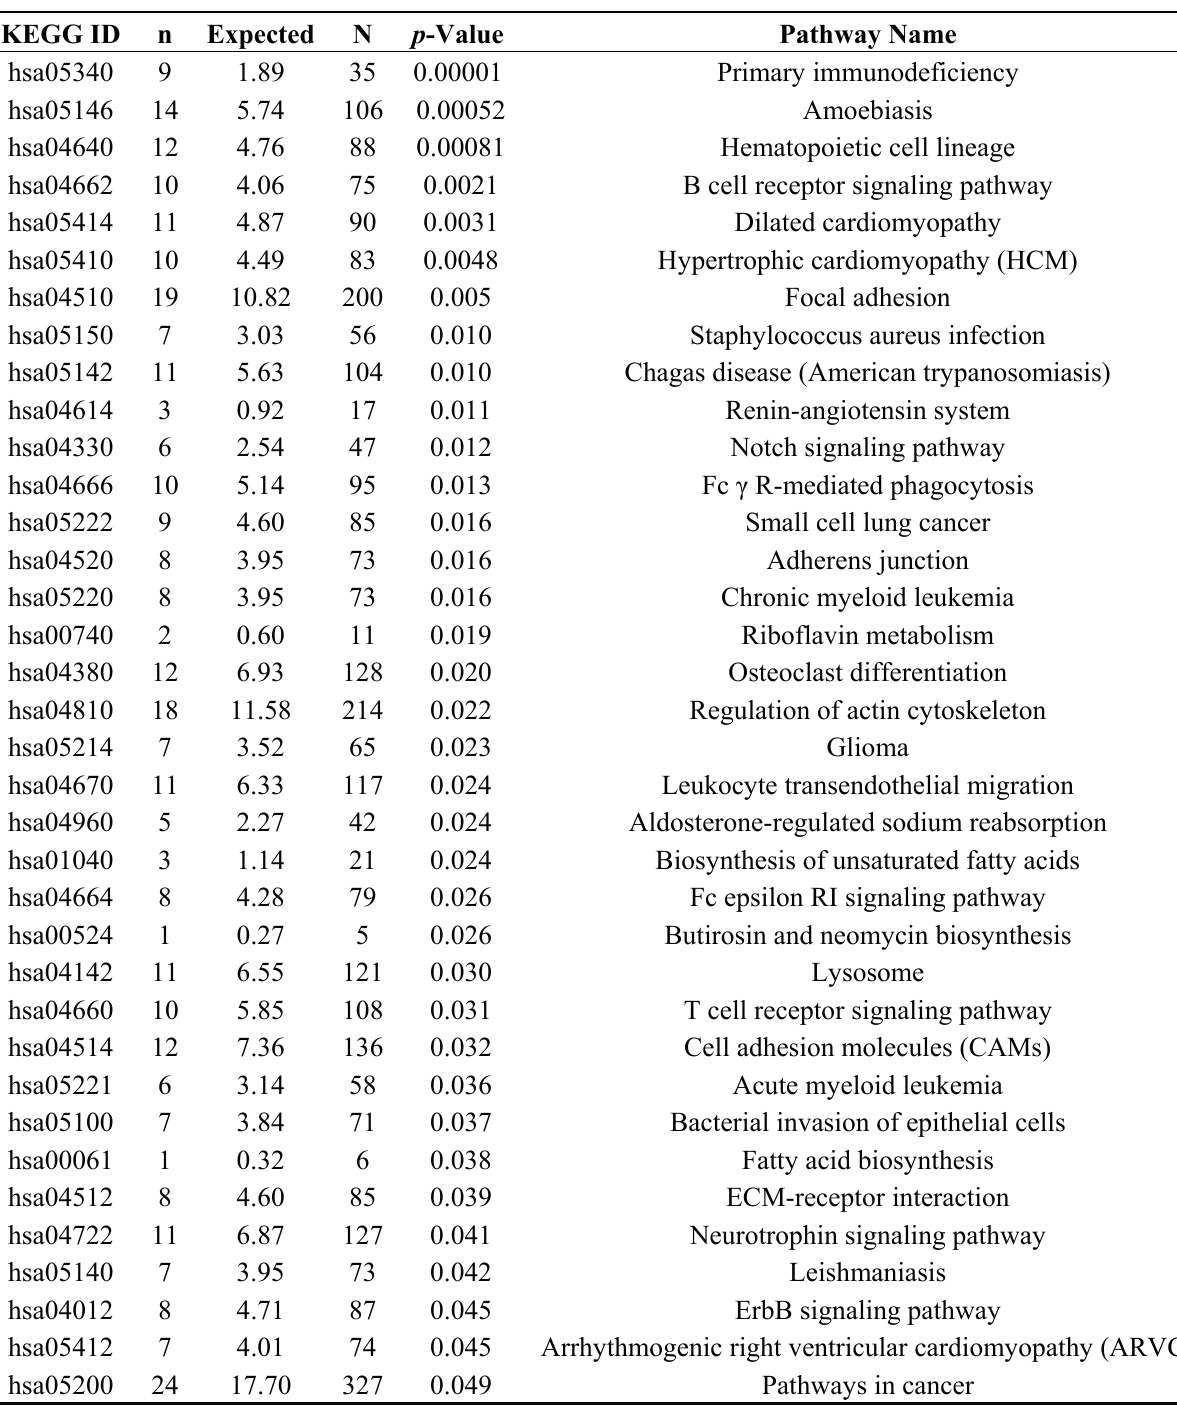
Table 10. Enriched KEGG pathways for the target genes identified in ChIP-chip with human AAA tissue and transcription factors RUNX1, ELF1, ETS2 and